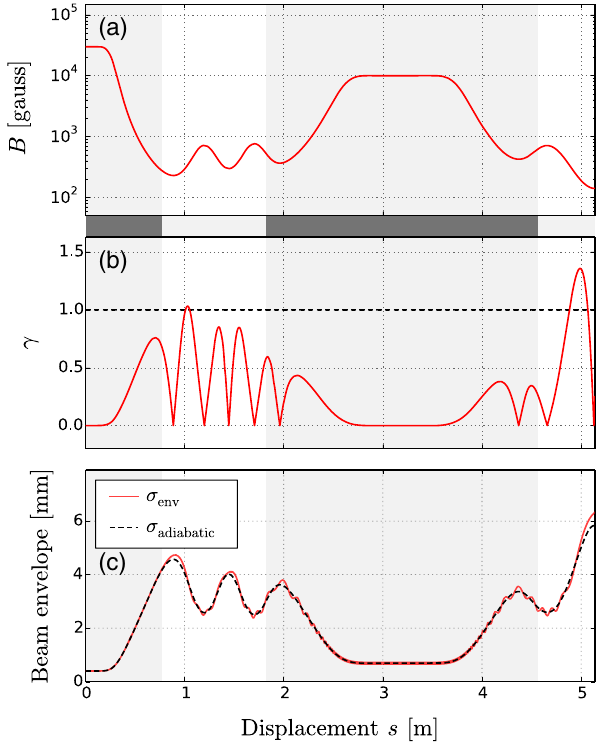
FIG. 3. Beam dynamics plots for a 50-eV ¯ p bunch extracted along beam path A, as shown in Fig. 1. (a) shows the on-axis magnetic field strength, while (b) shows the adiabaticity param- eter γ , and (c) shows two semianalytical solutions for the beam envelope. The horizontal axis has been shaded to match Fig. 1.